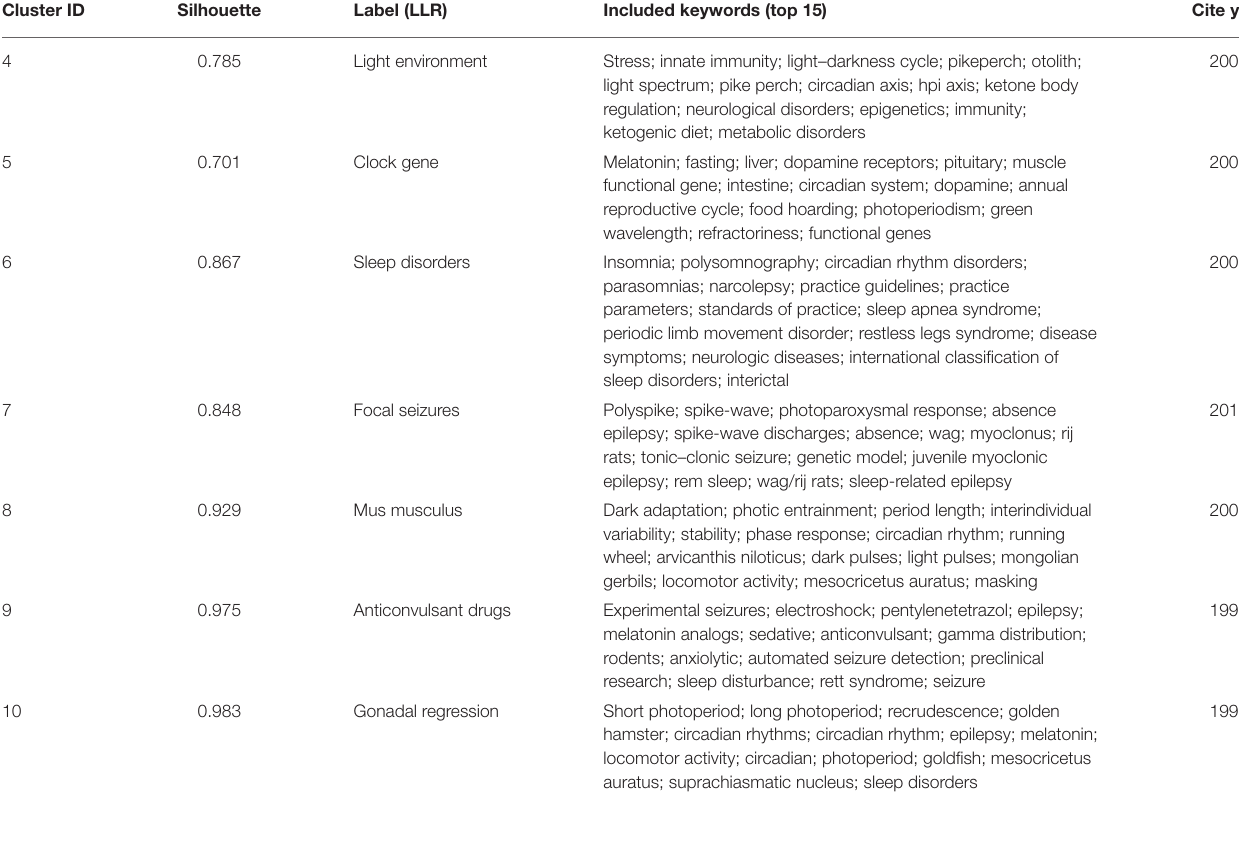
TABLE 5 | Keywords cluster analysis (the silhouette value is over 0.7). Cluster ID Silhouette Label (LLR)